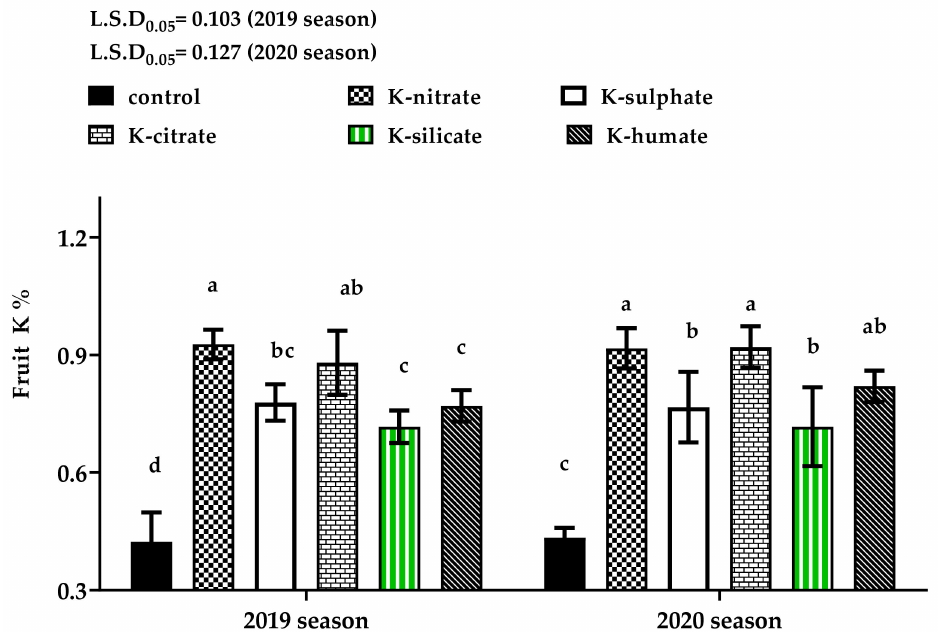
Figure 3. Effect of diverse potassium sources as foliar application on K% of ‘Canino’ apricot fruits in 2019 and 2020 seasons. Data represent the mean with SD. Letters above each bar shown indicating significant differences among the tested treatment, if letters were same corresponding treatments are statistically equal and vice versa according to Duncan’s multiple range tests at p <